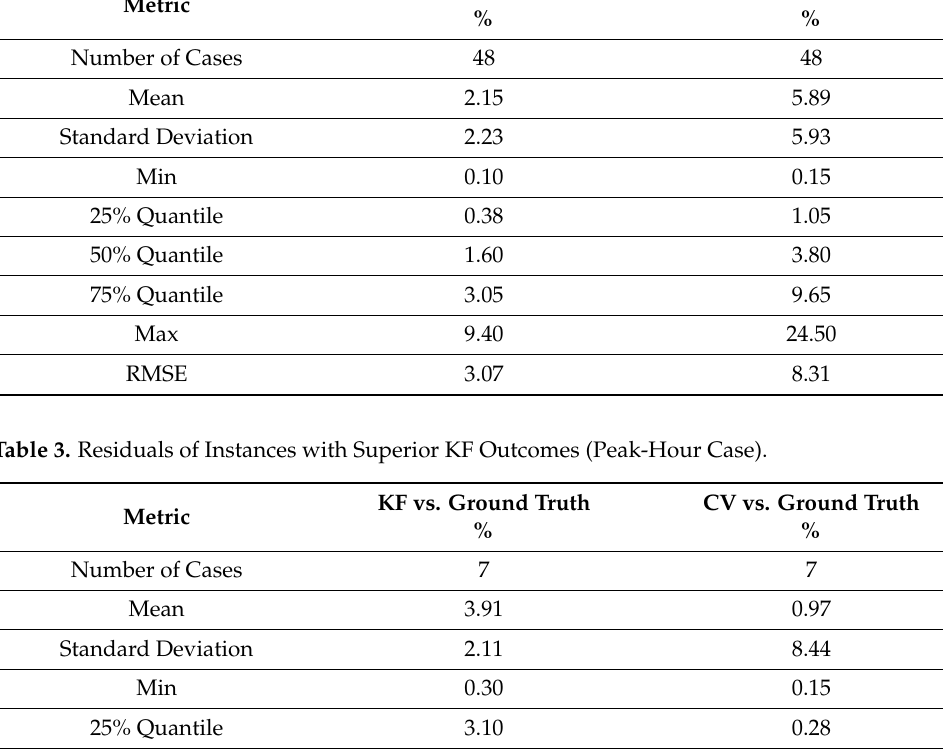
Figure 13. Comparison of CV, KF, and Observed TM Percentages for 4:15 – 6:15 p.m. 20 January 2021. Table 2. Residuals of CV and KF Predictions vs. Ground Truth (Peak-Hour Case). KF vs. Ground Truth Metric